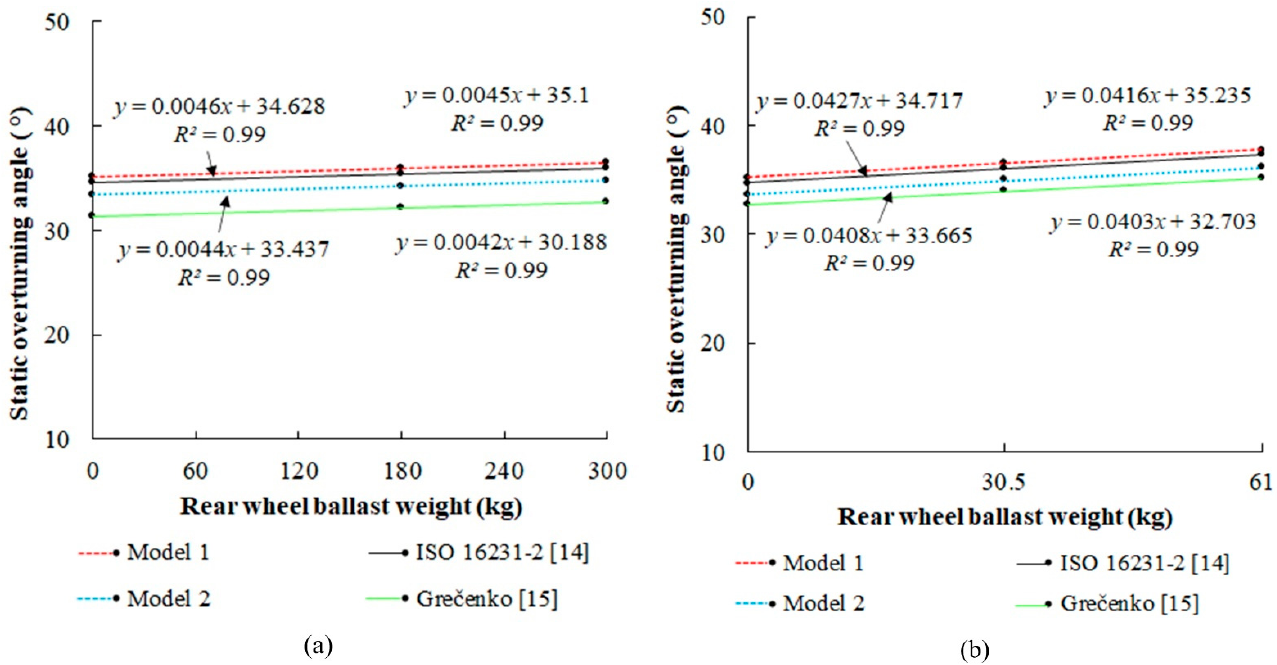
Figure 11. Comparison of [14,15], Model 1, and Model 2 at medium overall tire width: ( a ) Universal tractor; ( b ) Subcompact tractor.